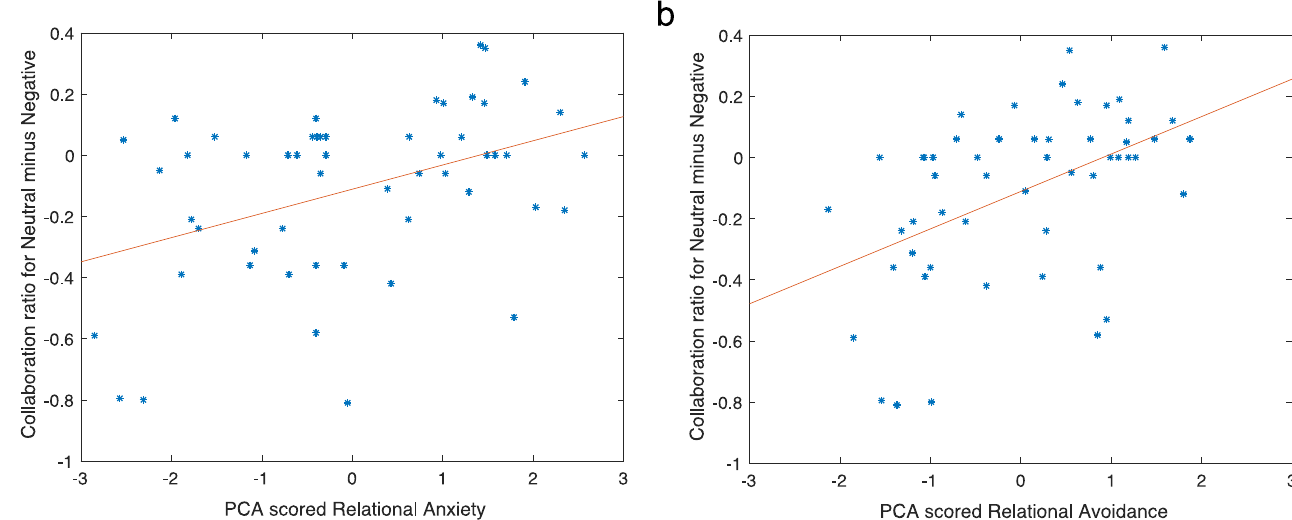
Fig 6. Correlation between shared PCA attachment scores and cooperation ratio. Differences in the cooperation ratio across negative and neutral environmental contexts correlated with shared PCA components for attachment relational score. High anxious individuals (on the left panel) tended to cooperate less when in a negative environmental context than when in a neutral environmental context. High avoidance individuals (on the right panel) were less likely to cooperate when in the negative context than in the neutral context.